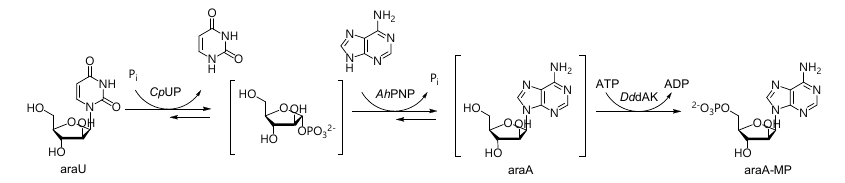
Scheme 1. Three-enzyme cascade reaction for the synthesis of araA-MP. Legend: araU (arabinosyluracil), P i (inorganic orthophosphate), araA (arabinosyladenine or vidarabine), araA-MP